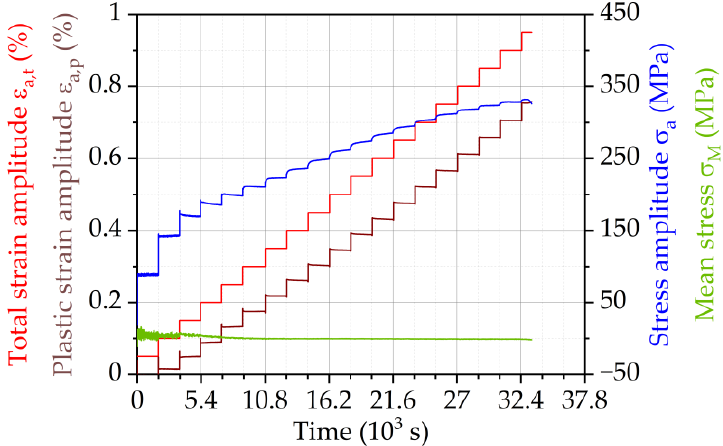
Figure 7. Results of a SIT at RT with ∆ ε a , t = 0.05% and ε a , t , start = 0.05%. ( a ) Material responses vs. time diagram; ( b ) Stress-strain hysteresis in the middle of each step.